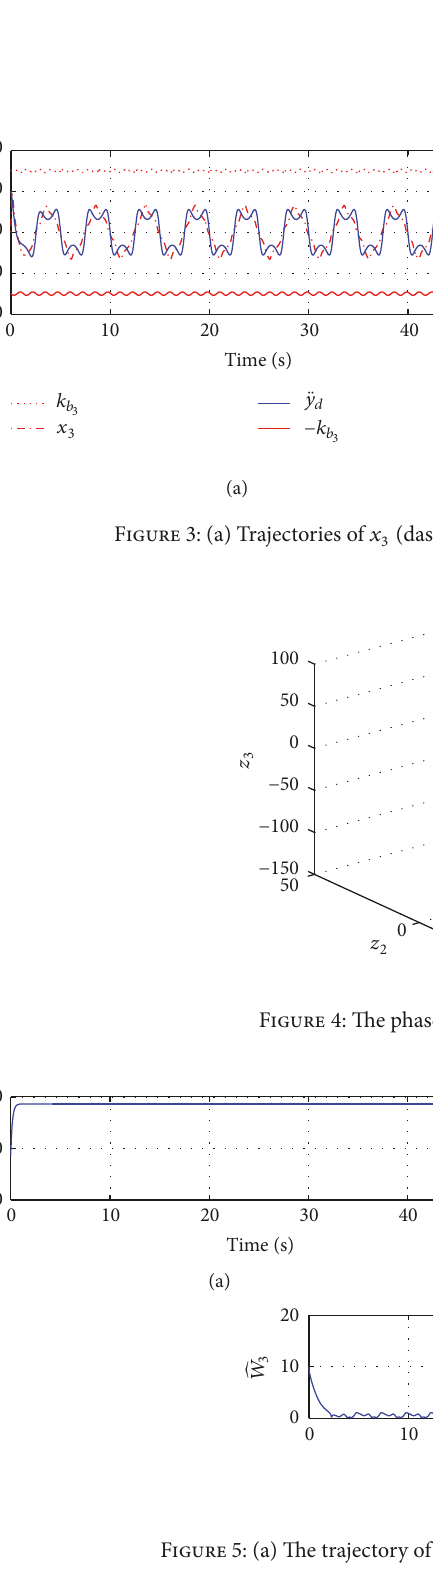
Figure 5: (a) The trajectory of